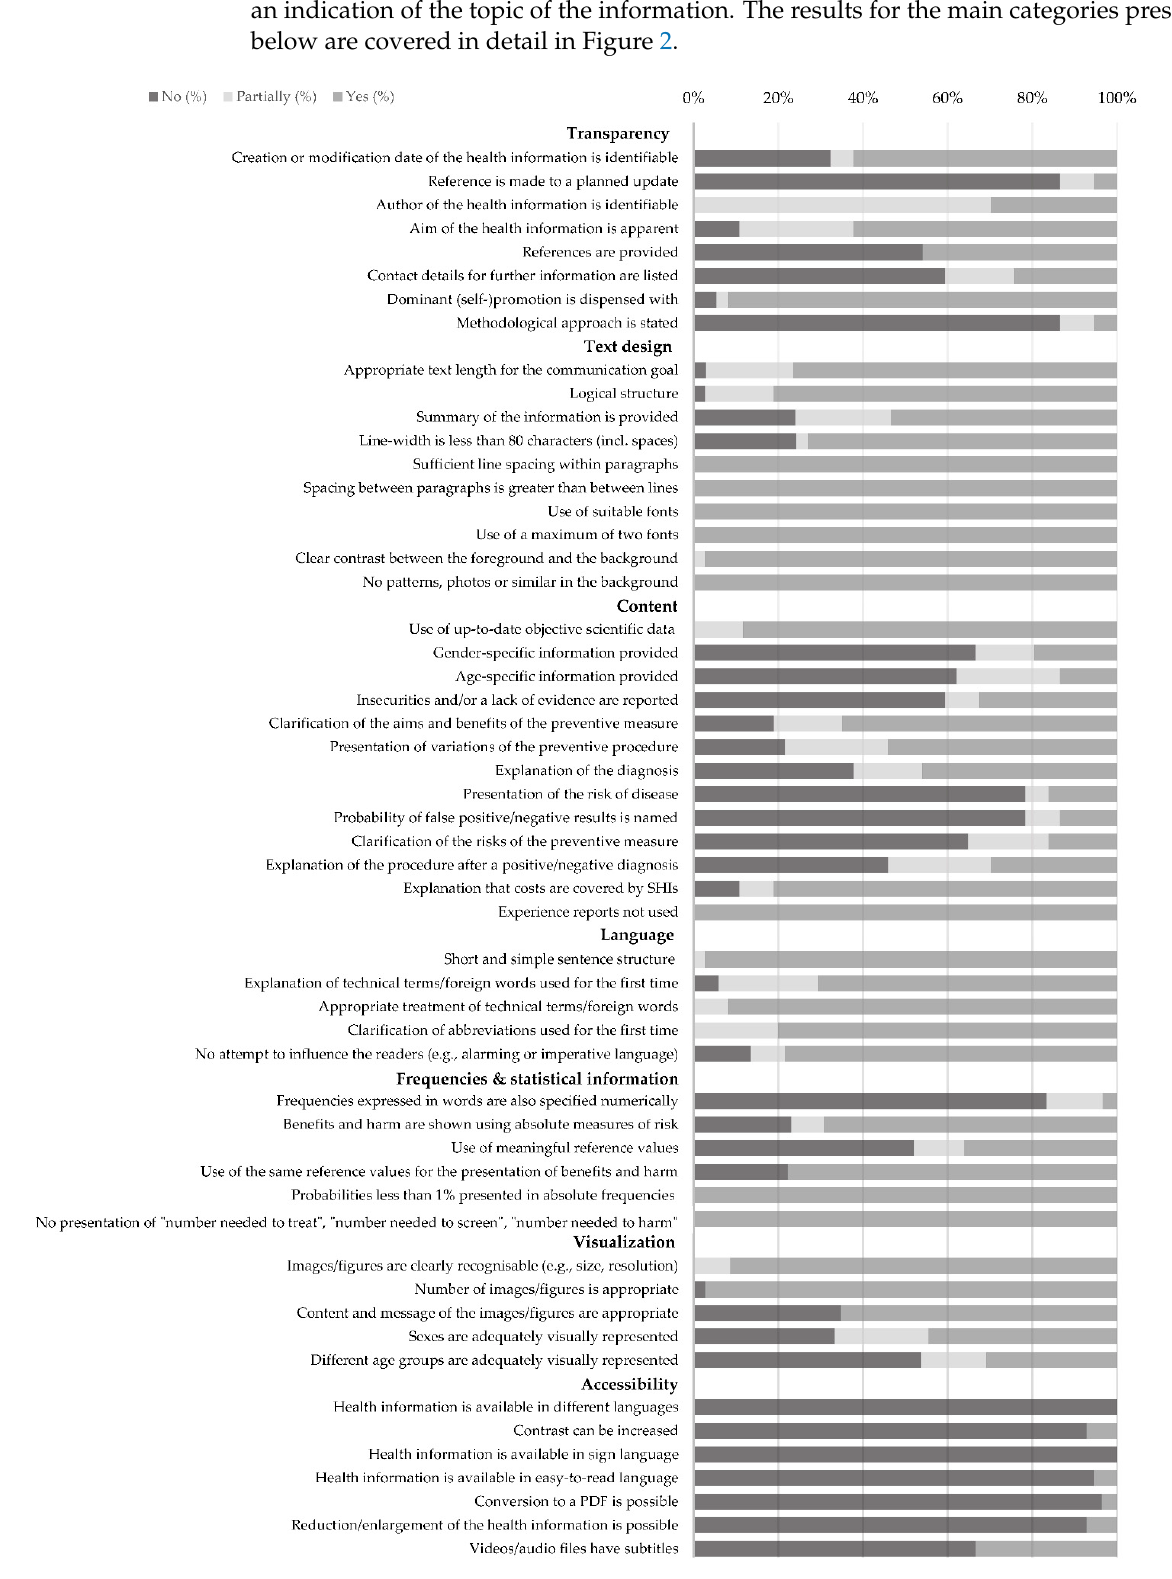
Figure 2. Results of evaluated health information on colorectal cancer screening (%).